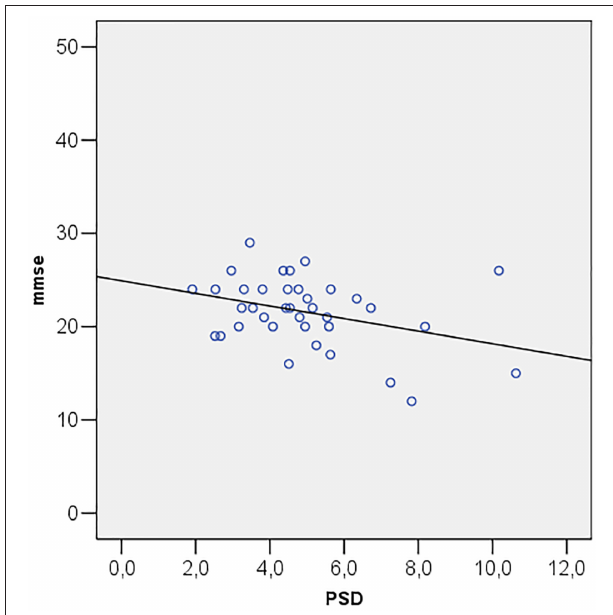
FIGURE 3 | Scatter plot of mini mental state examination (mmse) vs. pattern standard deviation (PSD).